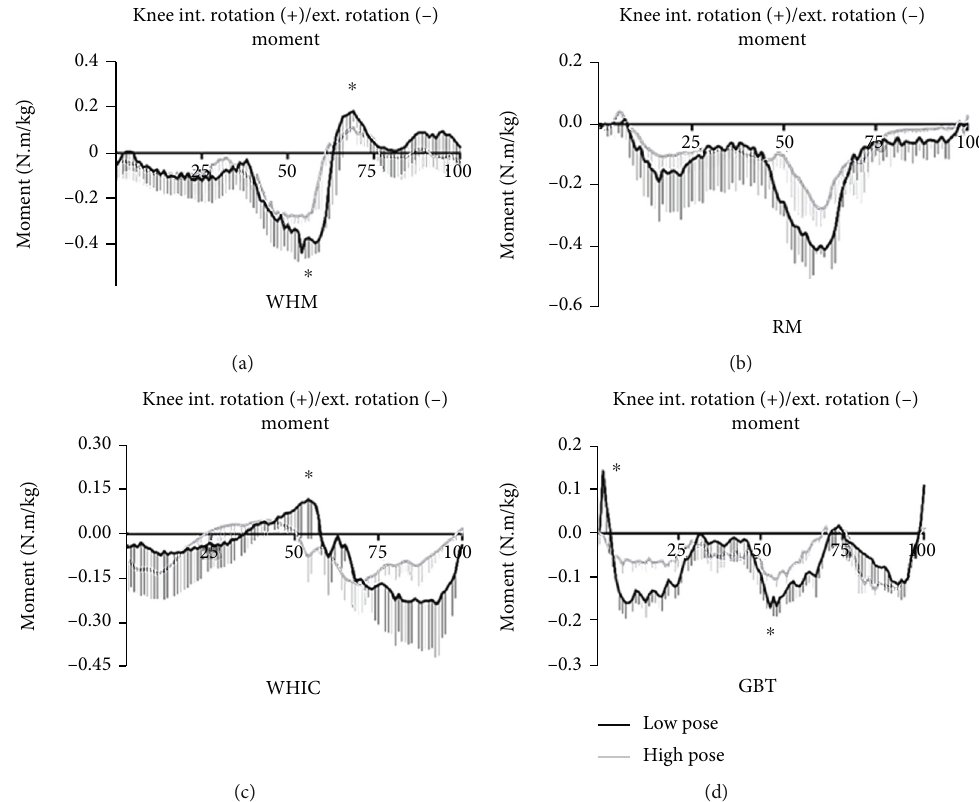
Figure 5: Joint moment at knee in transverse plane in high (black) and low (gray) pose for wild horse ’ s mane (WHM), repulse monkey (RM), wave-hand in cloud (WHIC), and grasp the bird ’ s tail (GBT) during one support phase ( N = 14 ). ∗ p < 0 : 05 . Table 2: Correlation analysis of knee joint range of motion (ROM) and center of mass (COM) displacement on knee joint load. Continuous